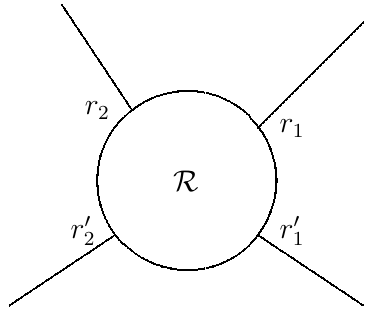
Figure 1 . A scattering process in which the particles interact strongly inside the region R via some unspeci(cid:12)ed forces, but outside the region R the only force operative between the particles is the long range gravitational